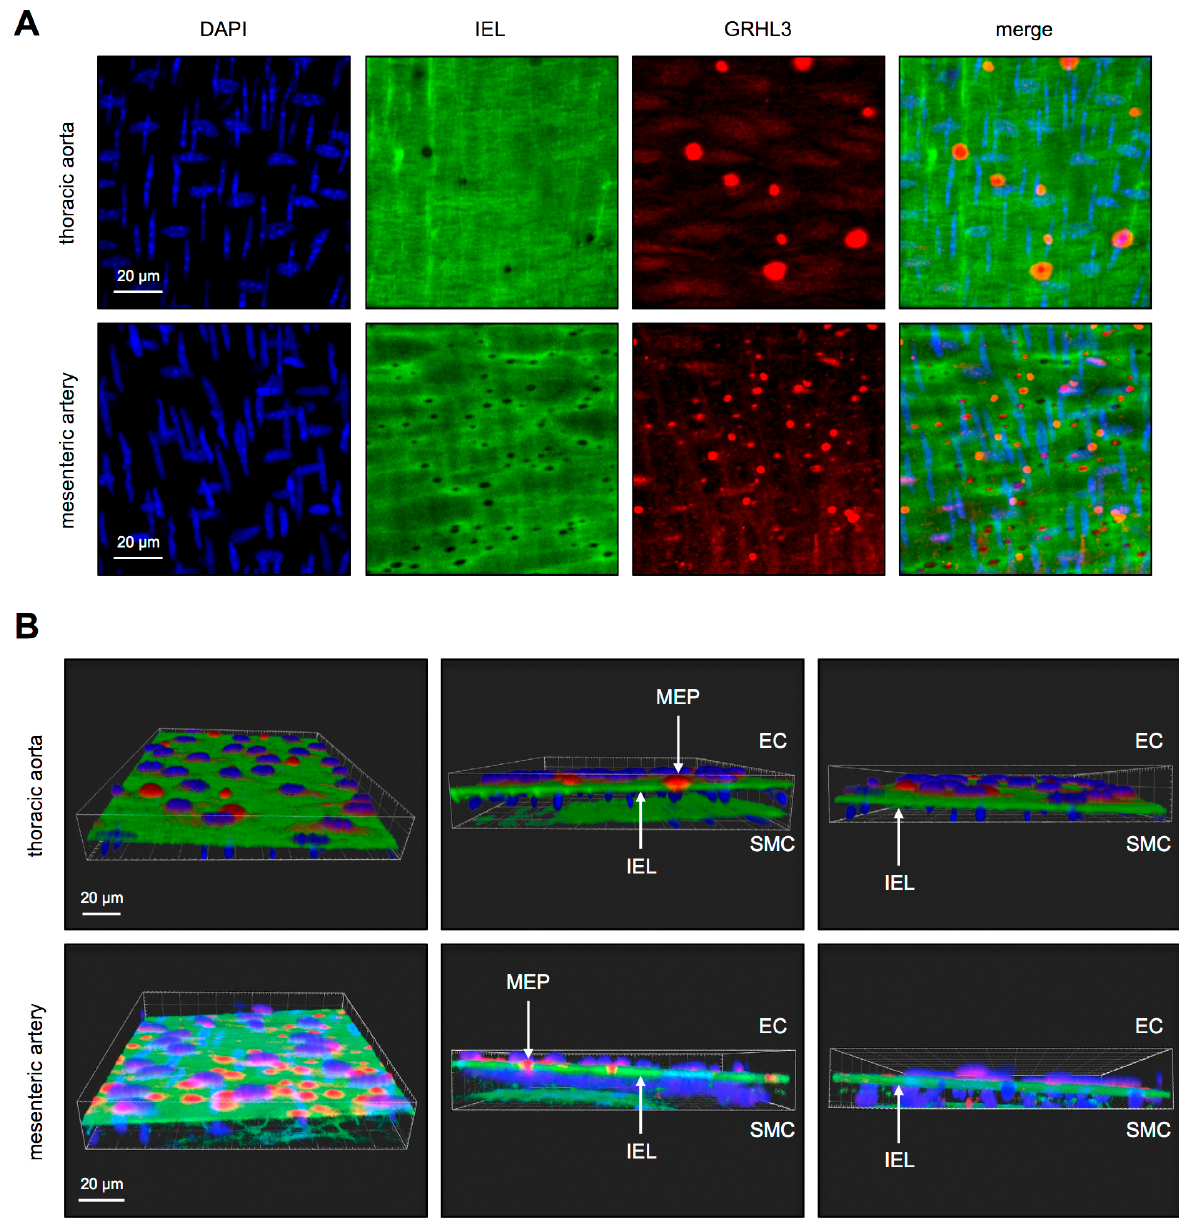
Figure 1. Transcription factor Grainyhead-like 3 (GRHL3) localization in the murine aorta and mesenteric arteries. ( A ) En face staining of the aorta (thoracic) and mesenteric arteries with an antibody against GRHL3 (red). Nuclei were counterstained with 4 ′ ,6-diamidino-2-phenylindole (DAPI) (blue). Horizontally-oriented nuclei are from endothelial cells and vertically oriented nuclei from smooth muscle cells. The internal elastic lamina (IEL) appears green due to autofluorescence. Black wholes in the IEL represent myoendothelial projections (MEP). Merge is the overlay of all channels. ( B ) Single frames from animated three-dimensional reconstructions of the aorta and mesenteric artery staining (see also Supplementary Videos). The endothelial cell layer (EC, top) is separated from the smooth muscle cell layer (SMC, bottom) by the internal elastic lamina (IEL). In the middle panels, MEPs are highlighted. Red staining represents GRHL3, which is only present in the endothelial cell layer, and blue shows the cell nuclei stained with DAPI.